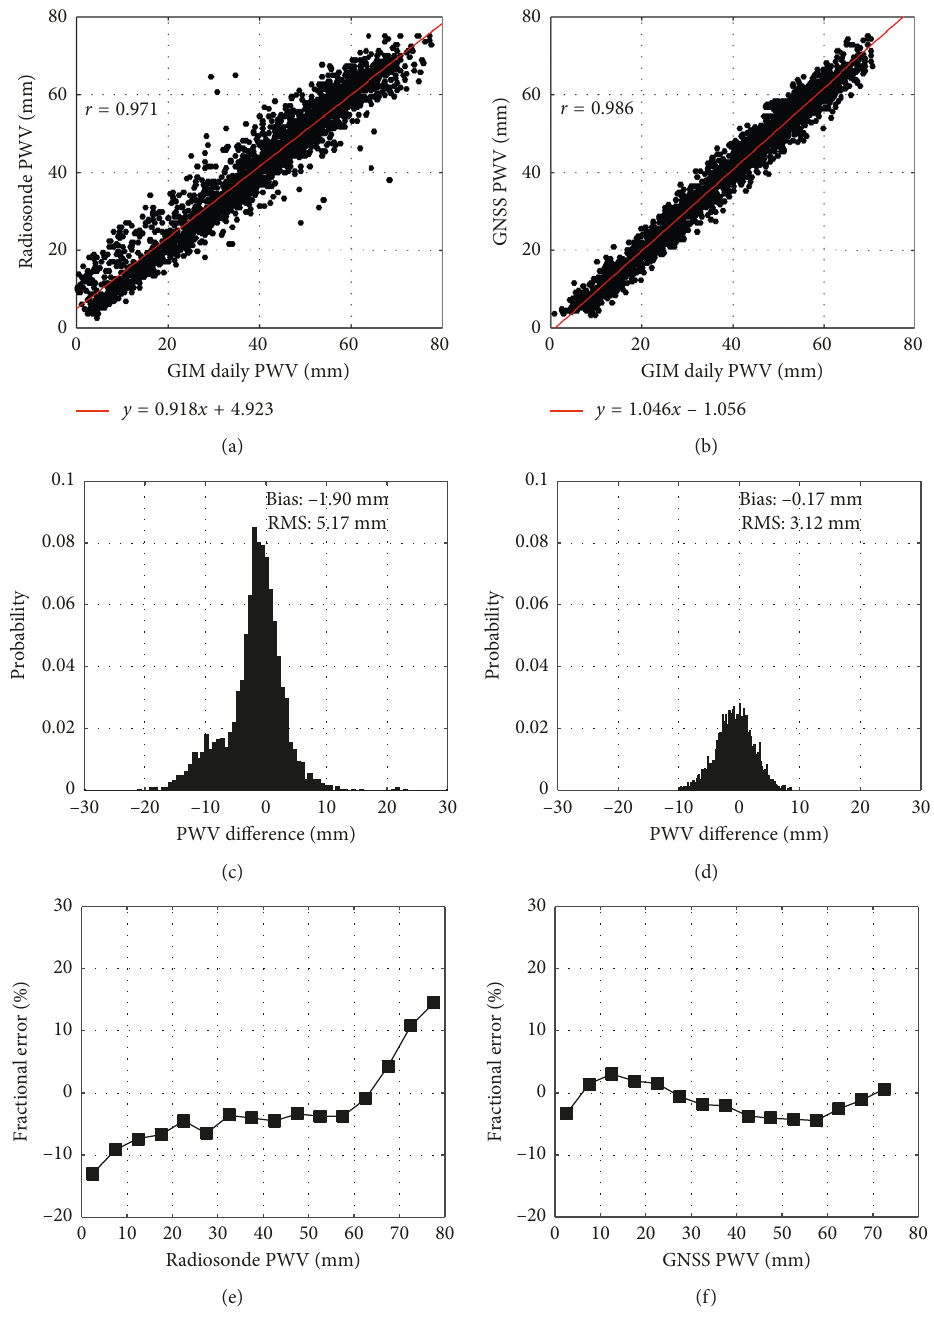
Figure 5: Scatter plots of (a) radiosonde PWV versus GMI daily PWV and (b) GNSS PWV versus GMI daily PWV, PDFs of PWV difference between (c) radiosonde and GMI daily and (d) GNSS and GMI daily, and fractional errors as percent by (e) radiosonde and (f) 5mm PWV